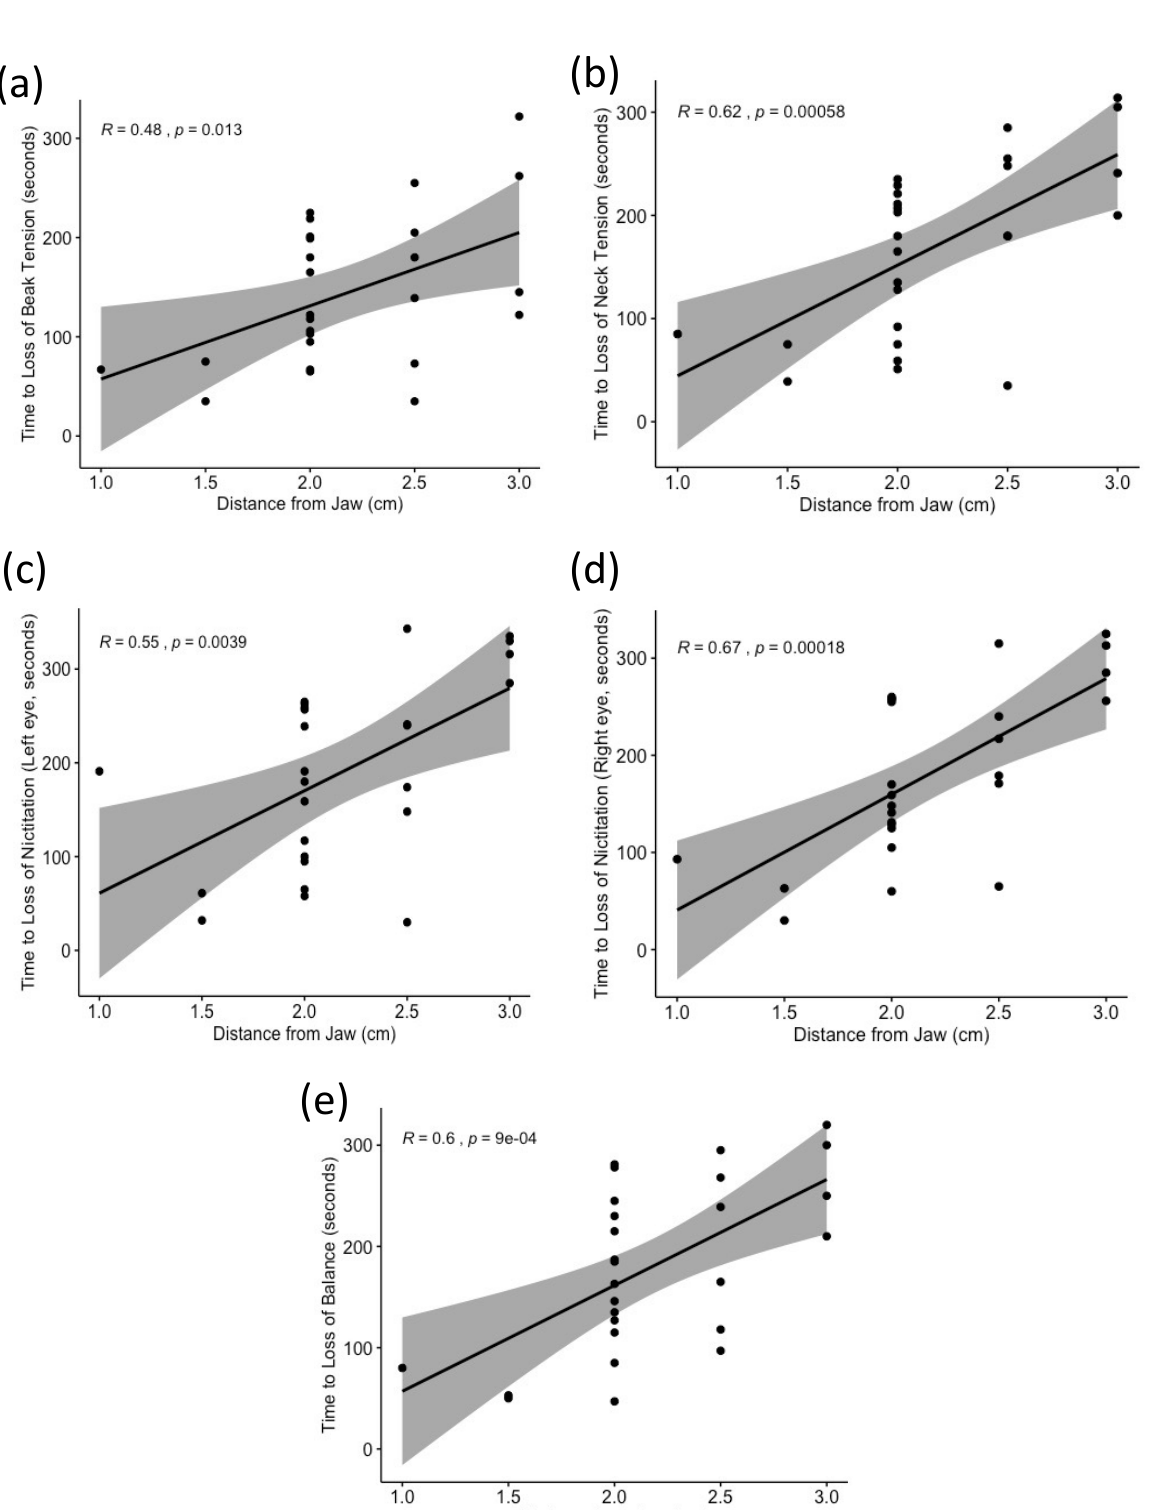
Figure 2. Correlation with confidence intervals between cut distance from jawbone (in centimeters) and behaviors/brainstem reflexes: ( a ) Time to loss of beak tension, ( b ) time to loss of neck tension, time to loss of nictitation in the ( c ) left and right ( d ) eye, and ( e ) time to loss of balance and. Each point represents a data point (bird). All correlations were significant at the p < 0.05 level.